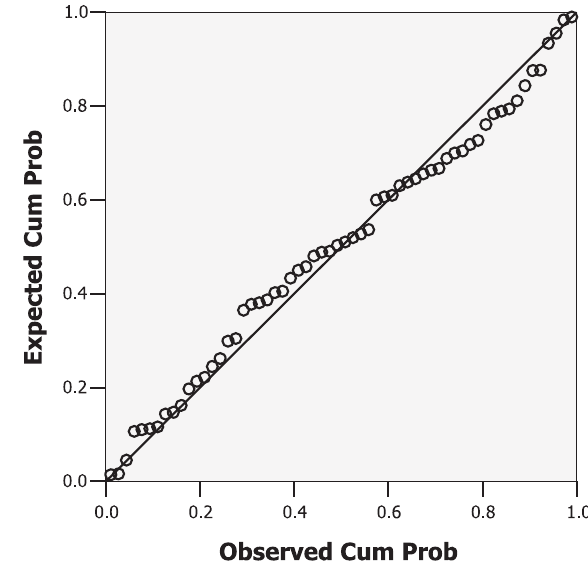
Fig. 1: Normal P-P Plot of Regression Standardized Residual, Dependent Variable: 293 R 0.2 p